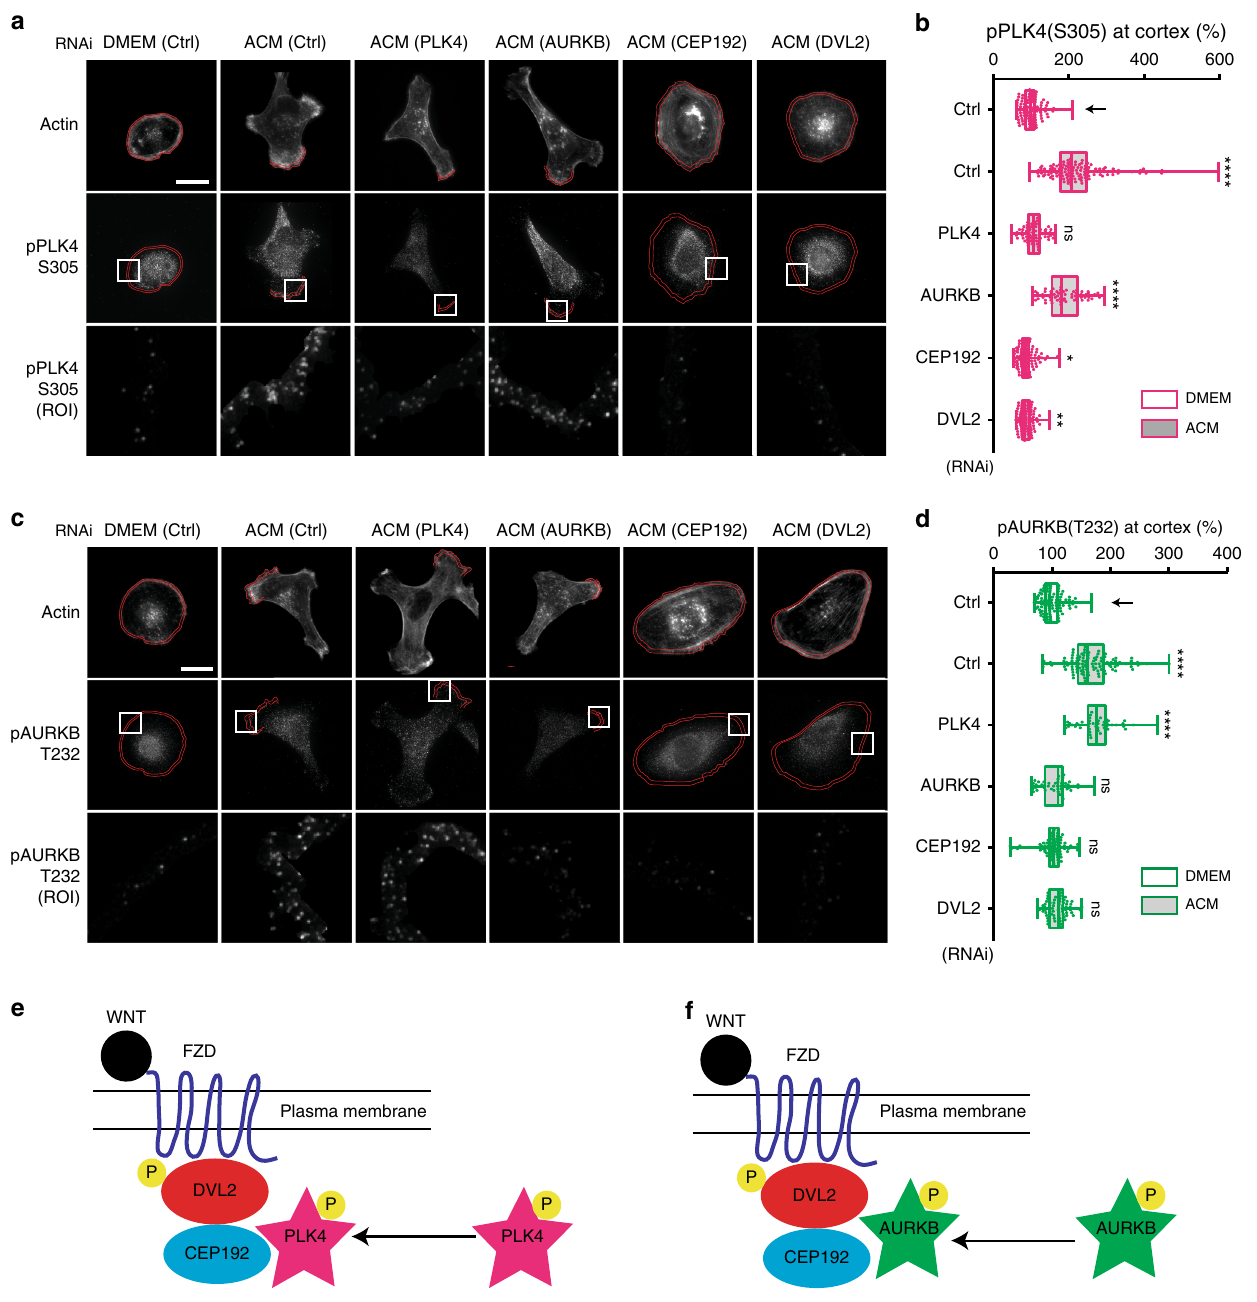
Fig. 7 DVL2 and CEP192 orchestrate the recruitment of PLK4 and AURKB at cell protrusions. a , c MDA-MB-231 cells transfected with control, PLK4, AURKB, CEP192 or DVL2 siRNAs were stimulated overnight with DMEM or ACM. Cells were stained for actin and ( a ) phospho-PLK4 (S305), or ( c ) phospho-AURKB (T232). Bar = 20 µ m. b, d Intensity of ( b ) phospho-PLK4 (S305), or ( d ) phospho-AURKB (T232) at cortical regions was measured from cells in ( a ) and ( c ), and plotted as box and whiskers. Boxes represent median and 25th to 75th percentiles, whiskers the minimum and maximum values with each individual value superimposed. The data are compared with one-way ANOVA Kruskal – Wallis test and post-tested with Dunn ’ s multiple comparison test. Arrow indicates the control bar used for comparison (* p < 0.05, ** p < 0.01, **** p < 0. 0001; n = 3, at least 60 cells were measured per condition). Magenta is phospho-PLK4, dark green is phospho-AURKB. Models for ( e ) phospho-PLK4 (S305) and ( f ) phospho-AURKB (T232) recruitment and localisation at the cell cortex to promote protrusion formation via DVL2 and